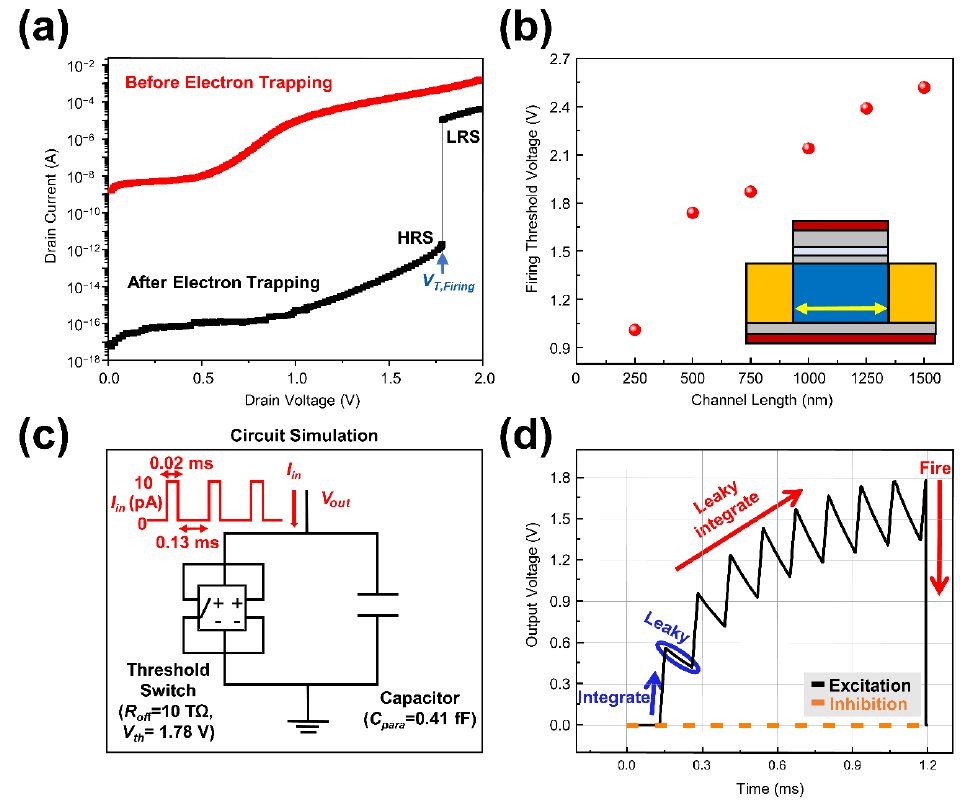
Figure 3. ( a ) I D -V D curves of the CSDG NW neuron device under inhibition mode and